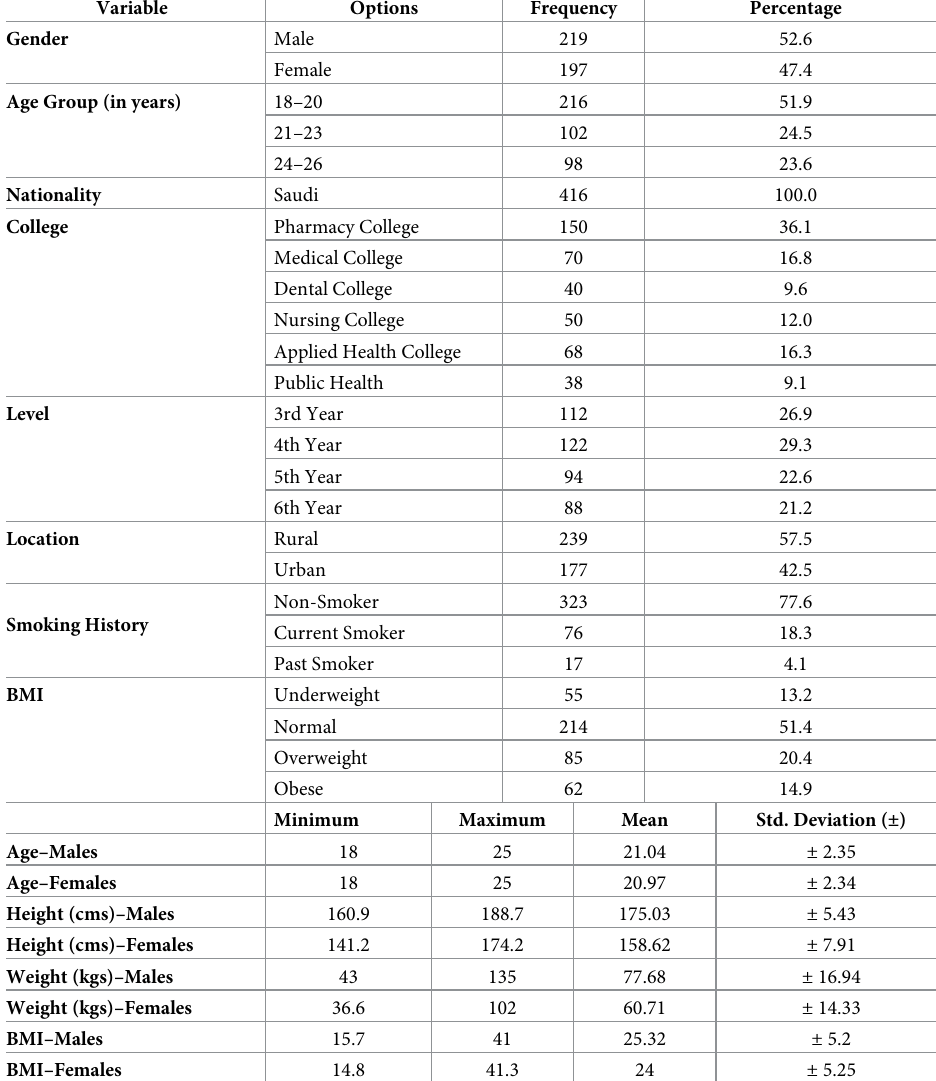
Table 1. Demographics / sample characteristics.